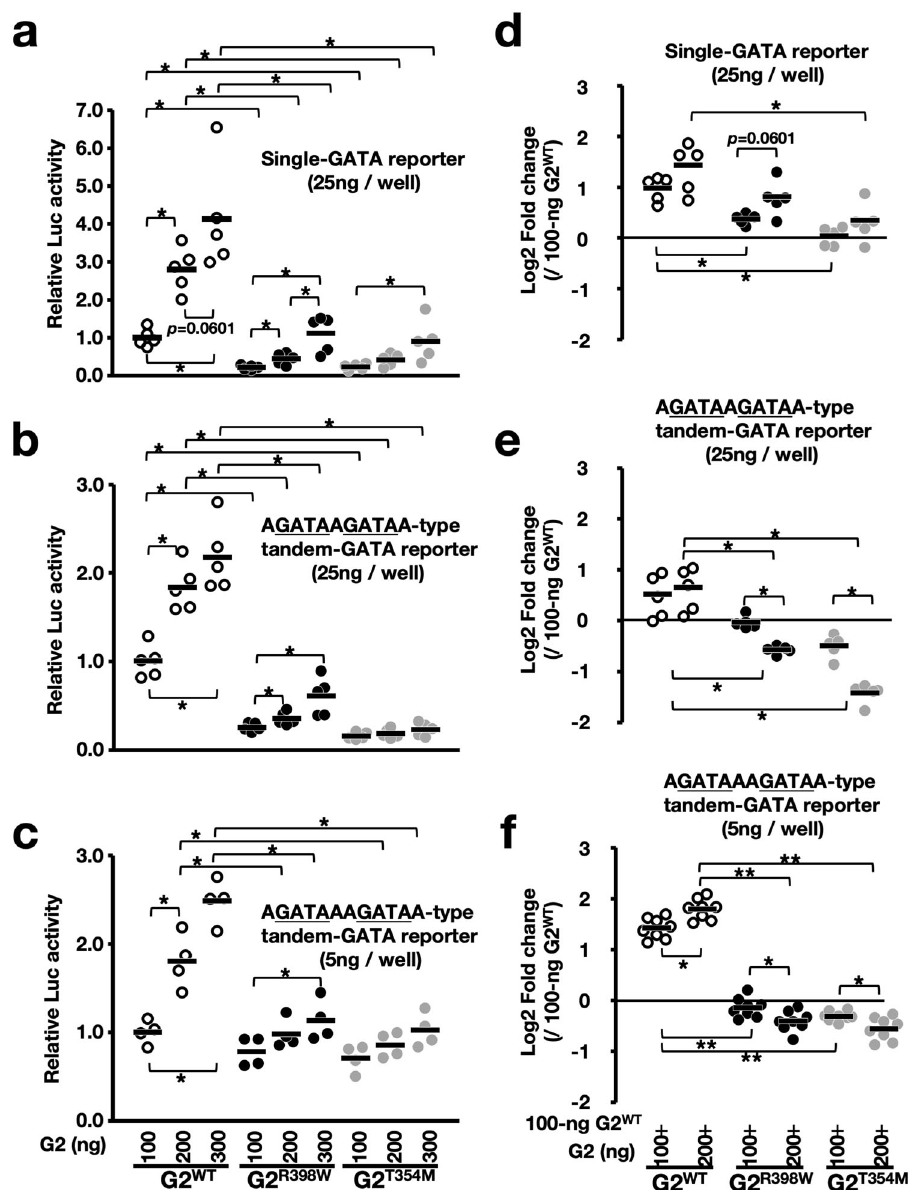
Fig. 8 Dominant-negative effect of G2 R398W and G2 T354M on transactivation activity. a – c Scatter dot plots of the transcriptional activity measured by luciferase reporter assay in HEK293T cells following transfection with luciferase reporter constructs containing single ( a ) and tandem ( b , c ) GATA motifs together with the respective GATA2 expression constructs at doses of 100, 200, and 300 ng/well. AGATAAGATAA-type (middle) and AGATAAAGATAA-type (bottom) tandem GATA constructs were used for transient reporter/effector cotransfection assays. Upper and middle panels, n = 5 biologically independent samples and bottom panel, n = 4. d – f Similar sets of experiments in which 100 ng of the G2 WT expression construct and luciferase reporter construct containing single ( d ) and tandem ( e , f ) GATA motifs were concomitantly transfected with G2 WT , G2 R398W , or G2 T354M expression constructs at doses of 0, 100, and 200 ng/well. AGATAAGATAA-type (middle) and AGATAAAGATAA-type (bottom) tandem GATA constructs were used for transient reporter/effector cotransfection assays. Upper and middle panels, n = 5 biologically independent samples and bottom panel, n = 8. The average luciferase activity of G2 WT at a dose of 100 ng/well was set to 1.0 in a – c , and fold changes of the average value of 100 ng of G2 WT are shown in d – f . * p <